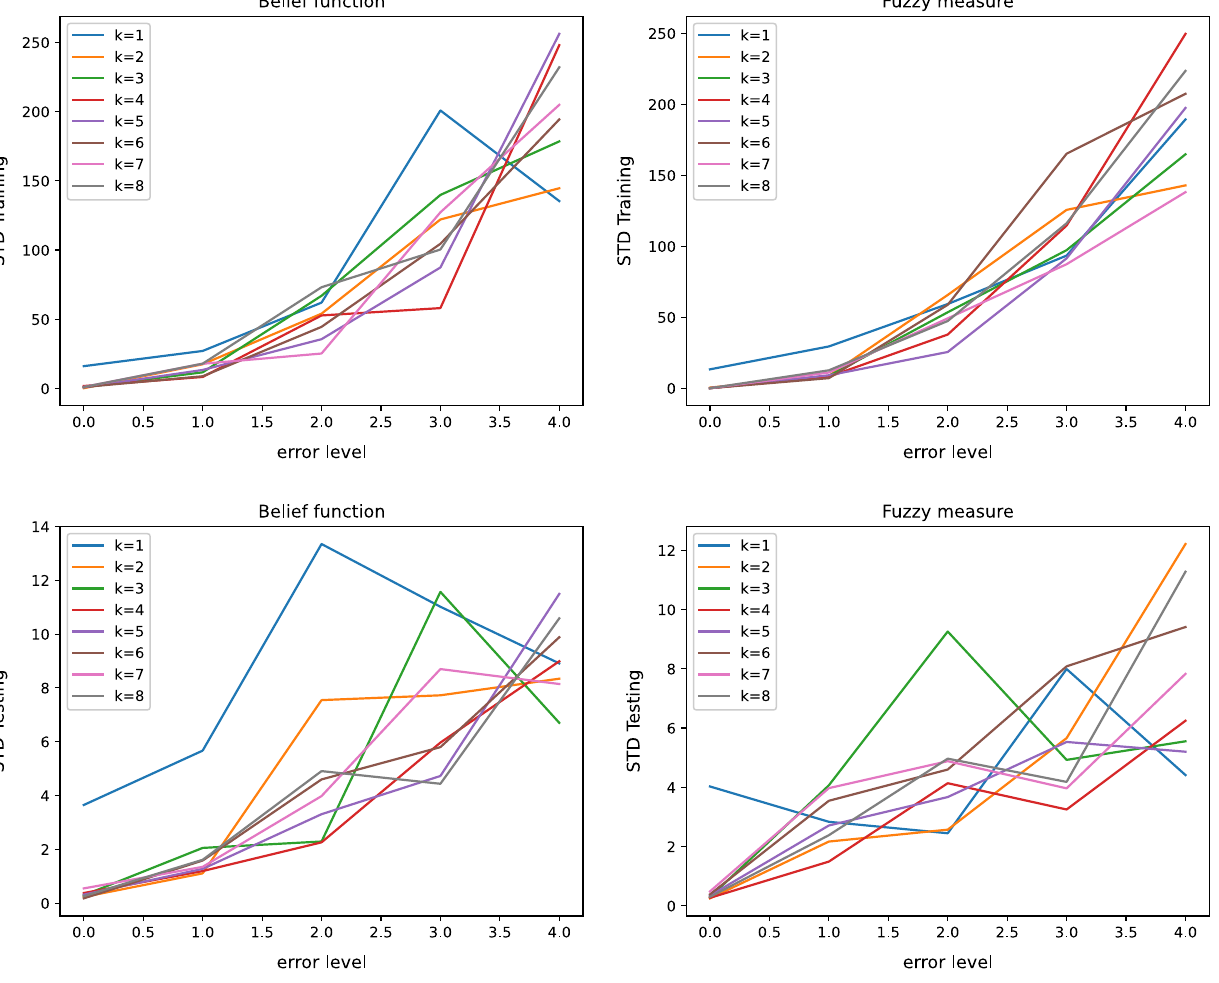
Fig. 4 Standard deviations for the training (top) and test (bottom) sets when the measure is a belief function (left) and when it is an arbitrary measure (right). Mean of 10